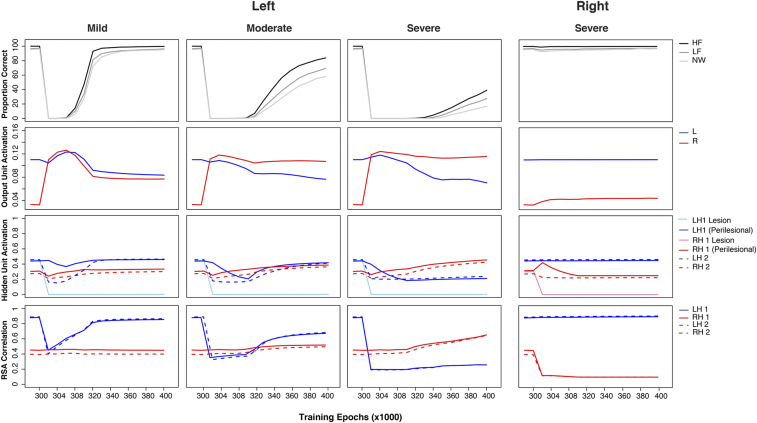
Simulation patterns of poststroke aphasia and recovery: left mild (20% [0.2]), left moderate (50% [0.5]), left severe (80% [0.8]), and right severe (80% [0.8]) conditions. The lesion level was a combination of the proportion (percent) of the units that was damaged and the range of noise (bracket) added to the connections to and from the hidden layer. For each lesion condition, the first panel shows model performance, the second panel shows output unit activation generated from the left and right pathway of the model separately, and the third panel shows hidden unit activation for the left and right hidden layers 1 and 2. The activations for lesioned and perilesional units are plotted separately; the fourth panel shows the RSA scores obtained in the left or right hidden layers 1 and 2 in the model. HF, high-frequency words; LF, low-frequency words; NW, nonwords; L, left; R, right; LH, left hidden layer; RH, right hidden layer.